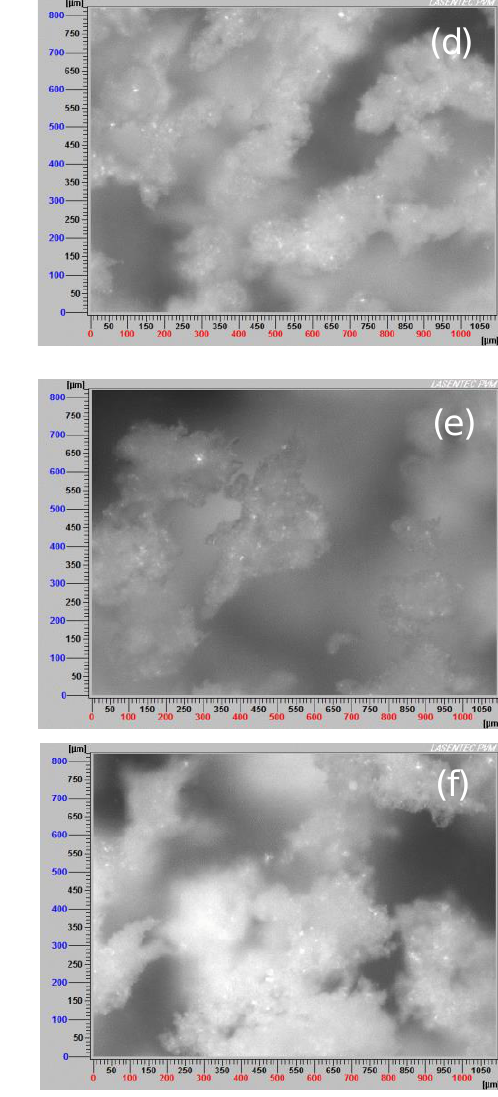
ferent doses of flocculant (50, 75, and 100 g/t) in IW (Frames a, b, c respectively) and SW (Frames d, e, f respectively) for a flocculation time of 15 s, fixed mixing rate of 180 rpm, and pH 7.